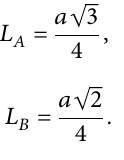
Figure 3: Nanoferrite particles X-ray difraction pattern of (a) CoFe (e) Co 0.2 Ni 0.8 Fe 2 O 4 , and (f) NiFe 2 O 4